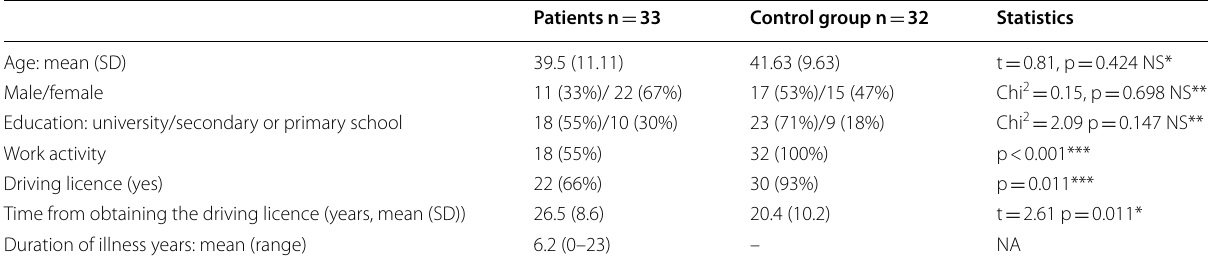
Table 2 Demographic and clinical characteristics of patients and the control